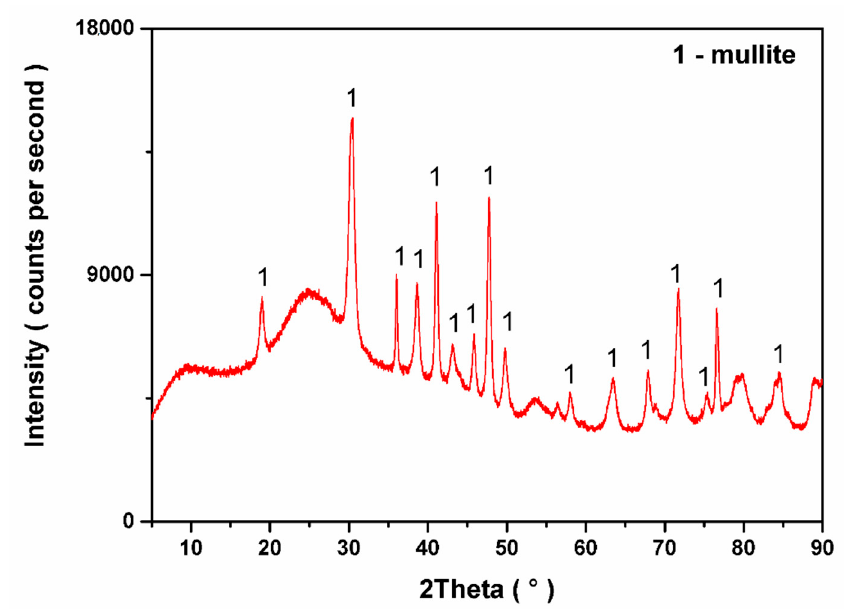
Figure 6. XRD patterns calcined at 1200 °C—mullite, start of α -Al 2 O 3 formation.